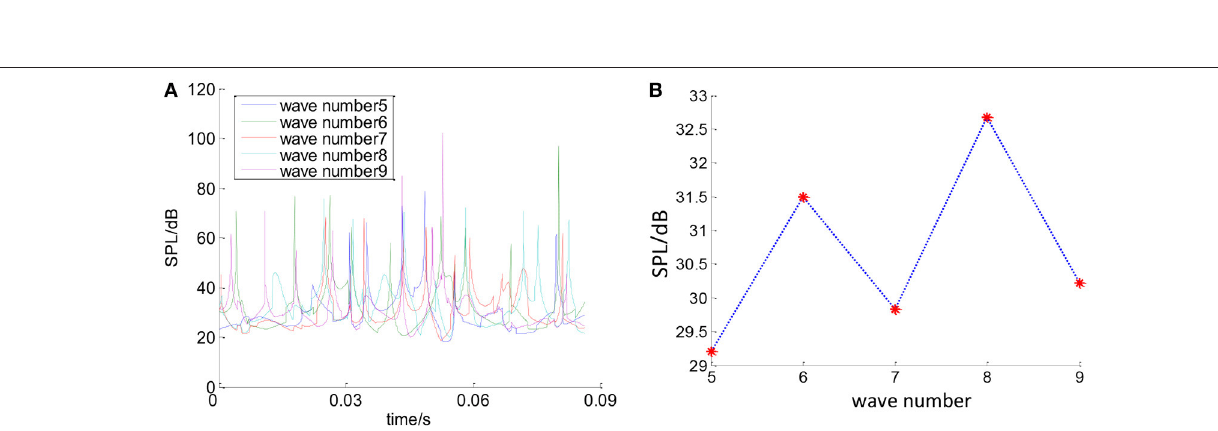
Frontiers in Mechanical Engineering |